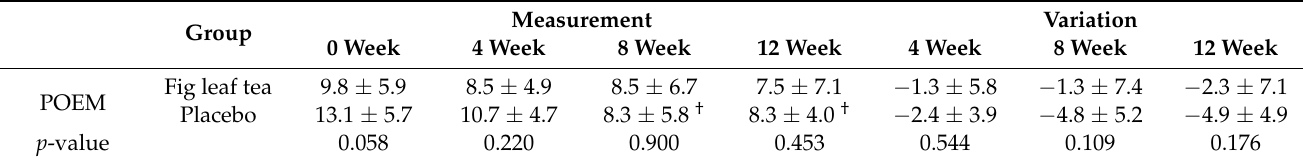
Table 4. Transition of